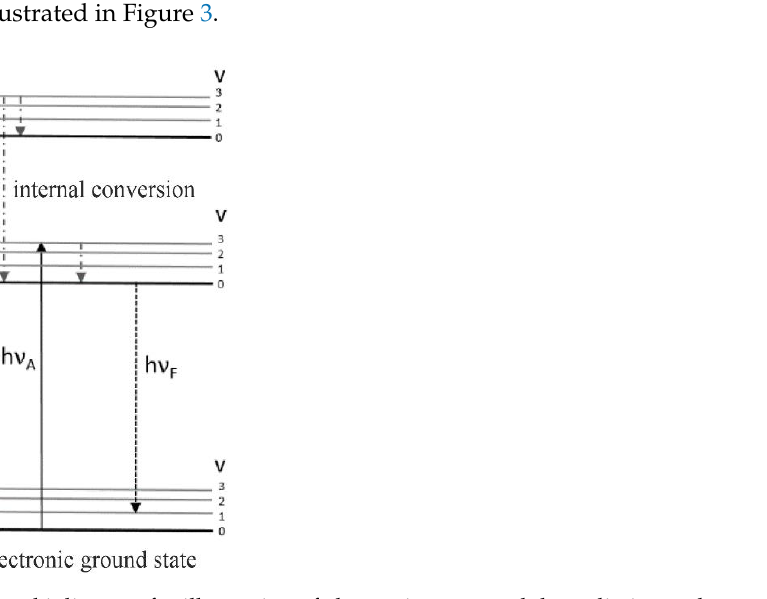
Figure 3. Jablonski diagram for illustration of electronic states and the radiative and non-radiative transitions between electronic states explaining fluorescence phenomena. Adapted with permission from [47]. Faassen and Hitzmann, 2016.